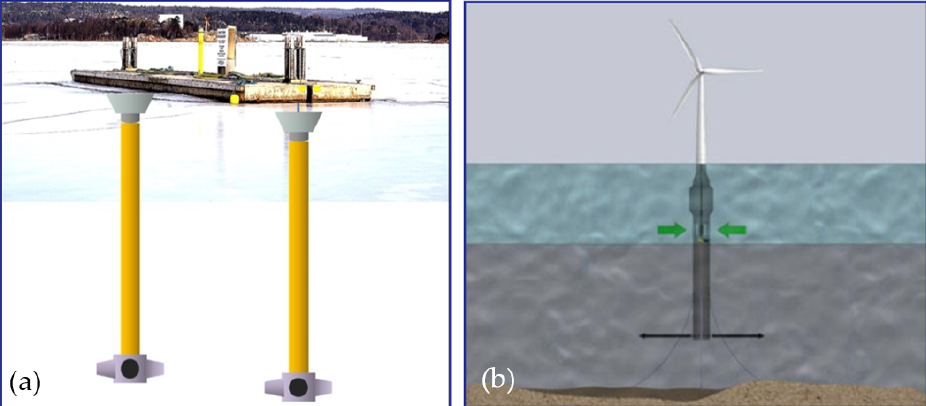
Figure 2. Schematic diagrams of the wind-powered pumping system [40], ( a ) The two pumping systems. ( b ) Underwater structure of pump.